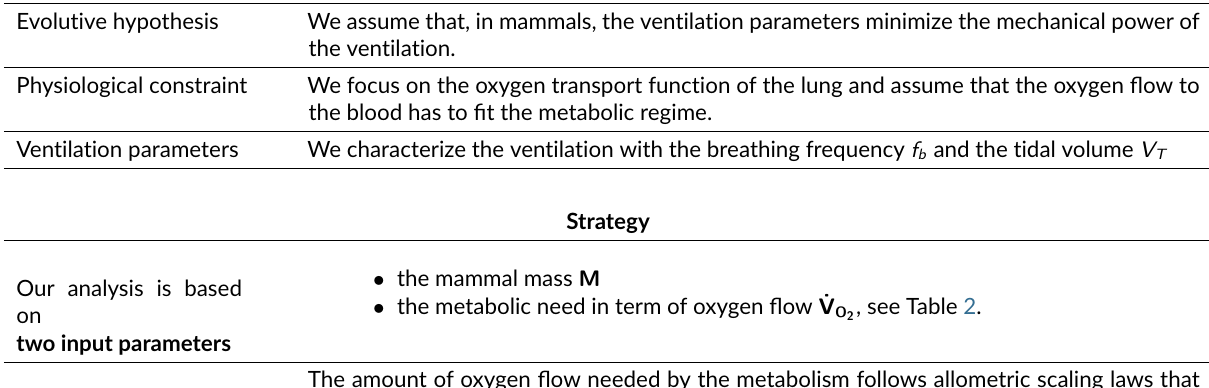
Table 4 indicates the methodology used in our analysis. Tables 5 and 6 on the next pages describe the hypotheses of the two models coupled in our work. Table 4 – General strategy and hypotheses.